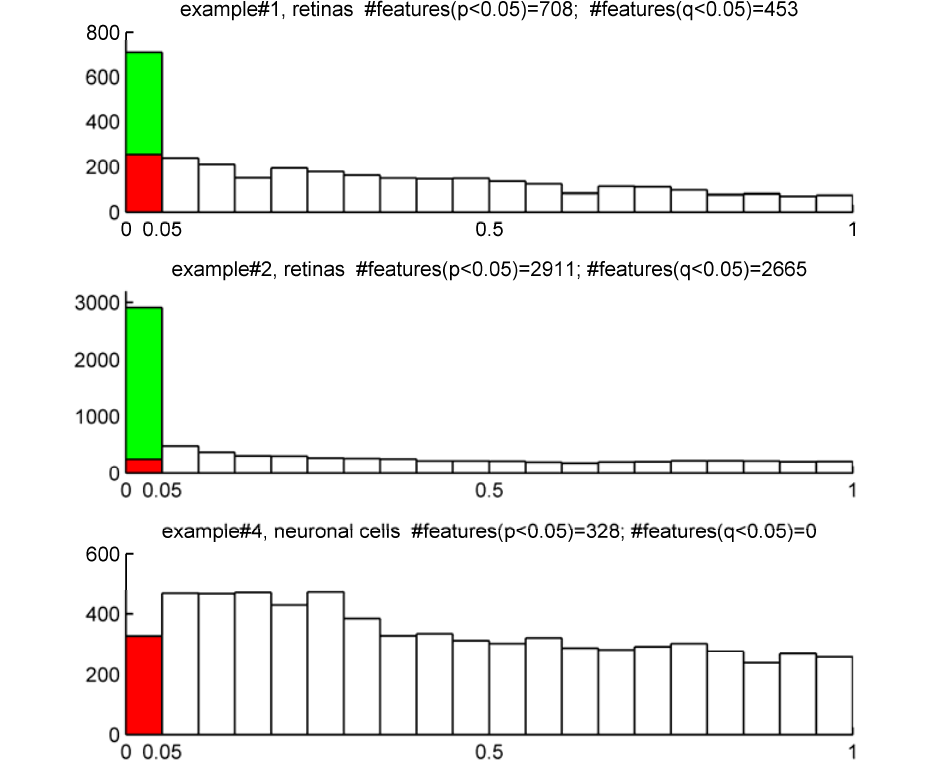
Figure 4. Frequency histogram showing the distribution of p-values typically expected from t-tests binary groups’ comparison in examples #1, 2 and 4. Green bar represent the total number of features declared to be significant assuming 5% false positives in a t-test comparison of the two groups. Red bar represent the FDR- estimated number of features being considered false positives out of the features declared significant in the t-test. The number of total significant features retained after FDR correction (q < 0.05) is also